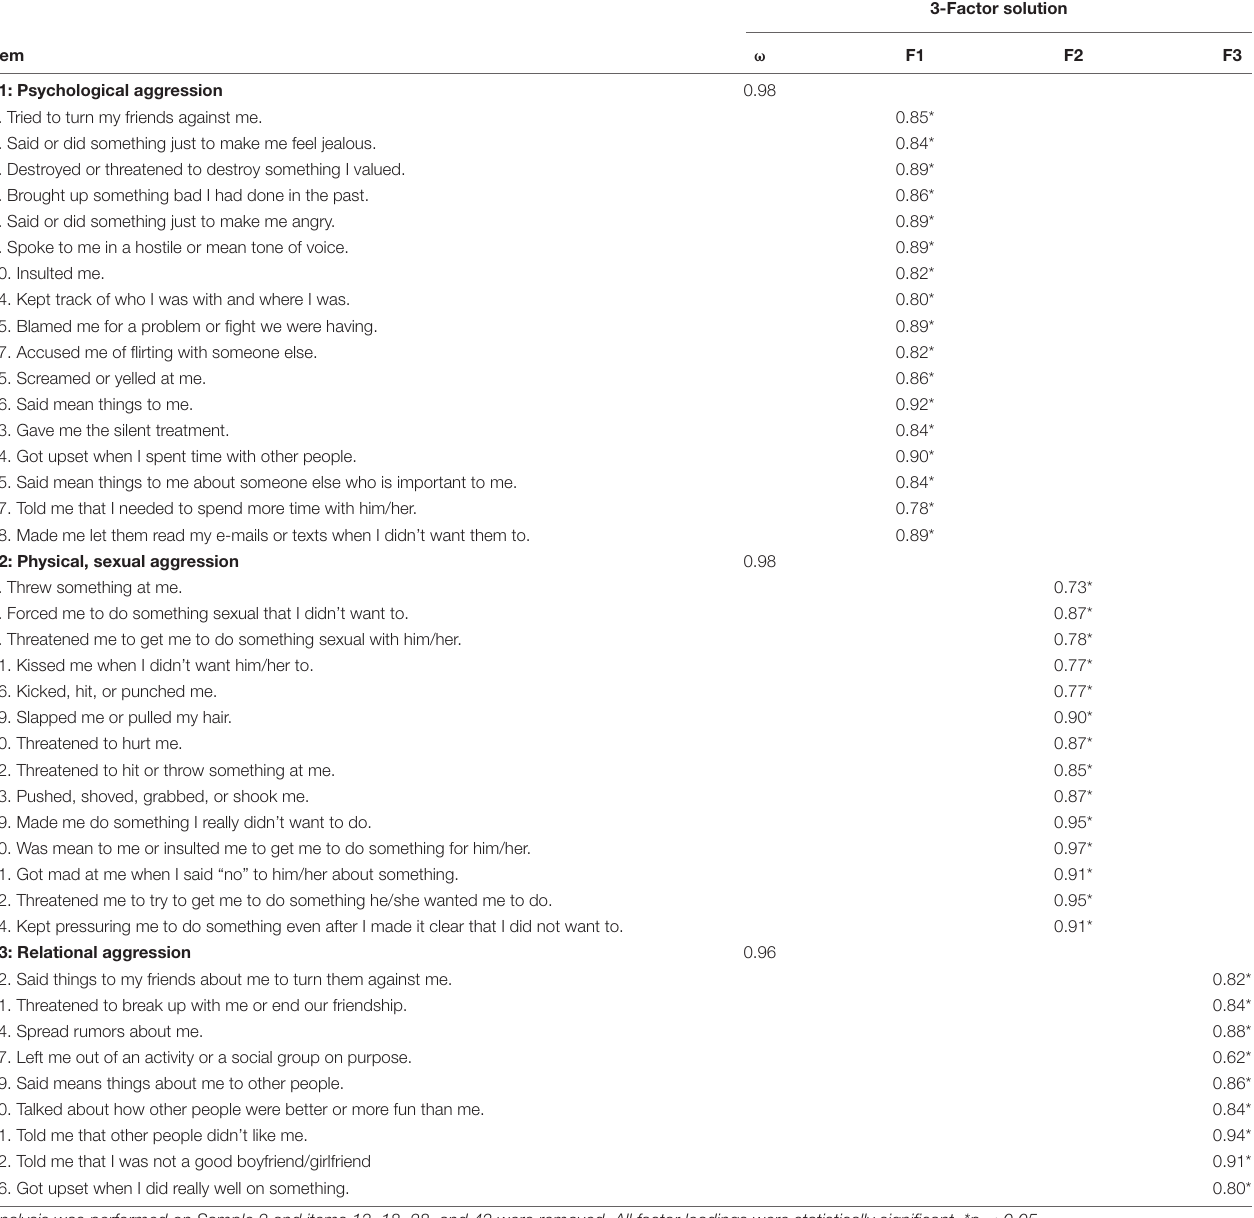
TABLE 6 | Confirmatory factor analysis standardized loadings and omega reliability estimates ( ω